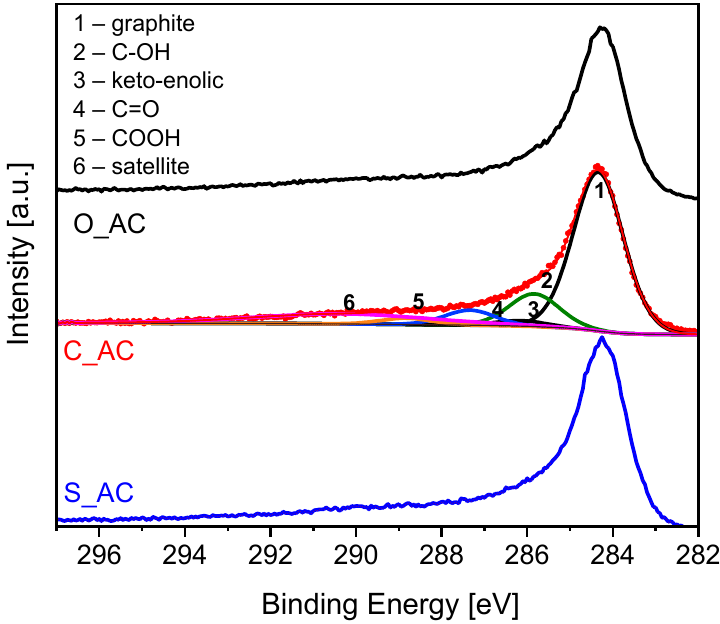
Figure 5. C 1 s X-ray photoelectron spectra; the components are indicated for the C_AC